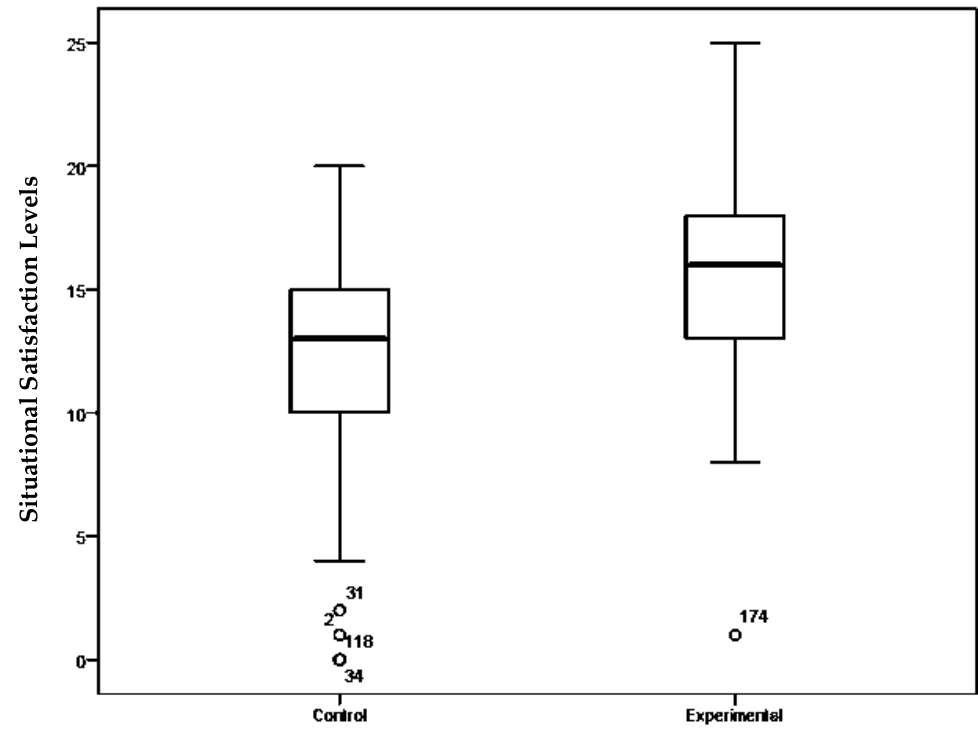
Figure 1. Satisfaction levels of the control and experimental groups in the post-intervention evaluation.